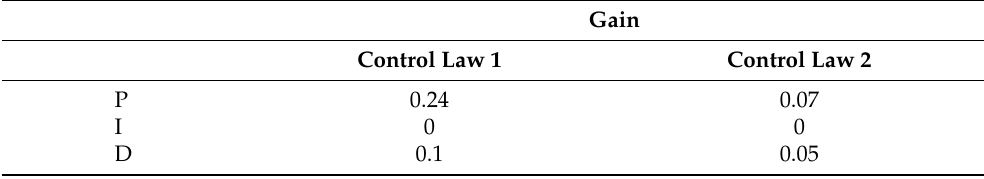
Table 3. Gain for position control law.